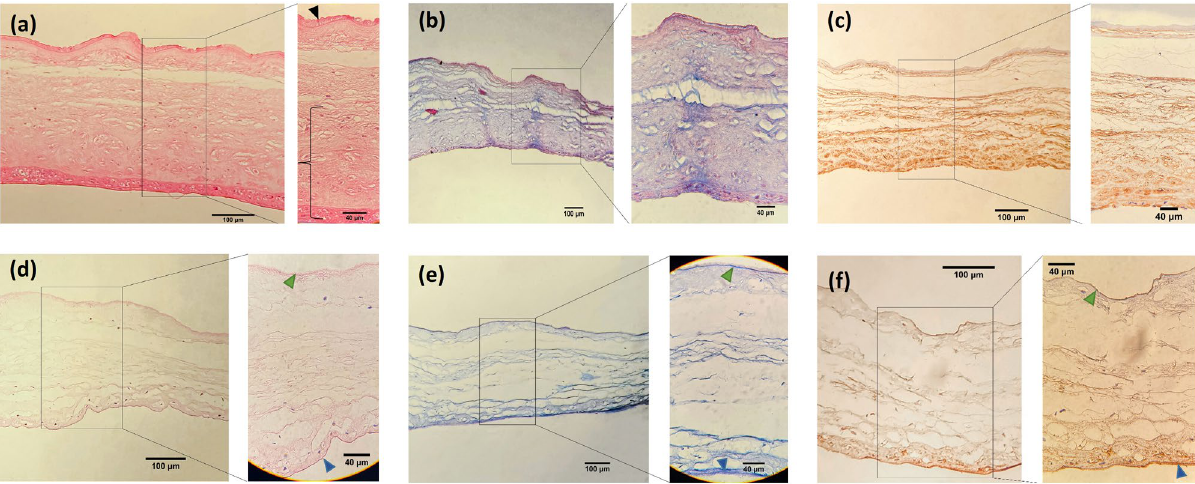
Figure 2. Histological features of fACM and dbACM; ( a ) H&E staining and ( b ) Mason’s trichrome staining of fACM; ( c ) IHC staining for collagen type IV in fACM; ( d ) H&E staining dbACM; ( e ) Mason’s trichrome staining of dbACM; ( f ) IHC staining for collagen type IV in dbACM; (black arrow: epithelial cells, black brace: trophoblasts, green arrow: amniotic basement membrane, blue arrow: chorionic basement